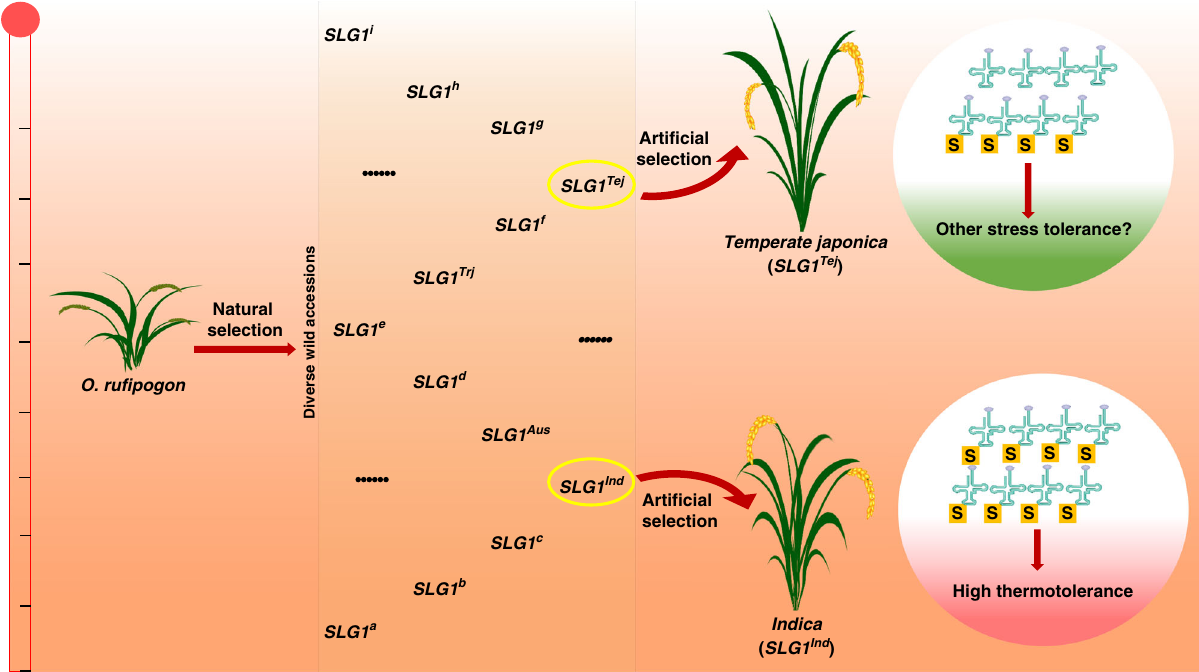
Fig. 7 Selection model of the SLG1 alleles during domestication. SLG1 is diversi fi ed among wild rice accessions. The intimate association of tRNA thiolation and thermotolerance led to the arti fi cial selection of the SLG1 Ind allele for the adaptation of indica rice to geographical regions with high environmental temperature. Interestingly, the SLG1 Tej allele was also subjected to selection during japonica domestication, which might be due to the dynamic response of tRNA thiolation to various environmental stresses 46